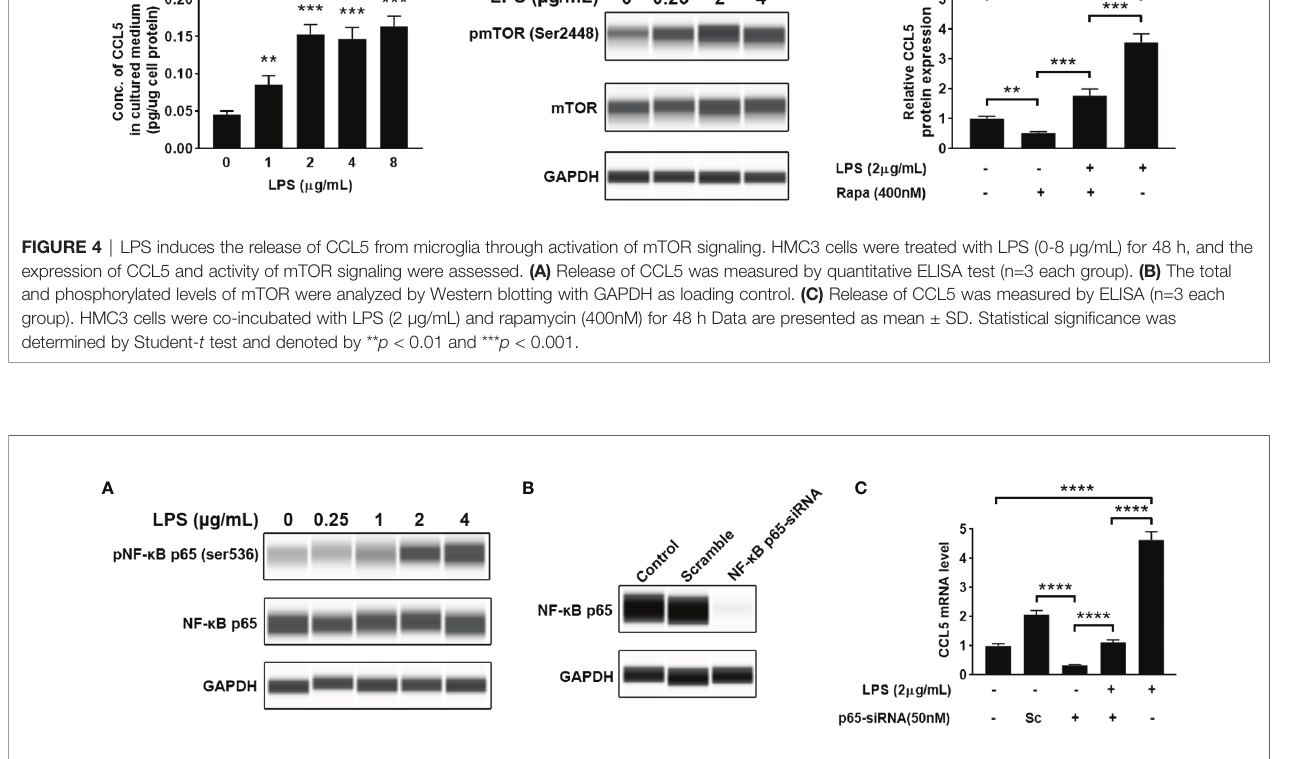
FIGURE 5 | NF- k B mediates CCL5 expression. (A) The total and phosphorylated levels of p65 subunit of NF- k B were analyzed by Western blotting with GAPDH as loading control. (B) The NF- k B p65-siRNA could ef fi ciently down-regulate the expression of p65. HMC3 cells were transfected with NF- k B p65-siRNA or scrambled control (Sc) for 48 h, and the cellular p65 protein level was analyzed by Western blotting. (C) The stimulating effect of LPS on CCL5 expression could be suppressed by NF- k B knockdown. LPS-stimulated HMC3 cells were transfected with siRNA for 48 h The mRNA expression level of CCL5 was determined by qRT-PCR (n=3 each group). Statistical signi fi cance was determined by Student- t test and denoted by **** p <